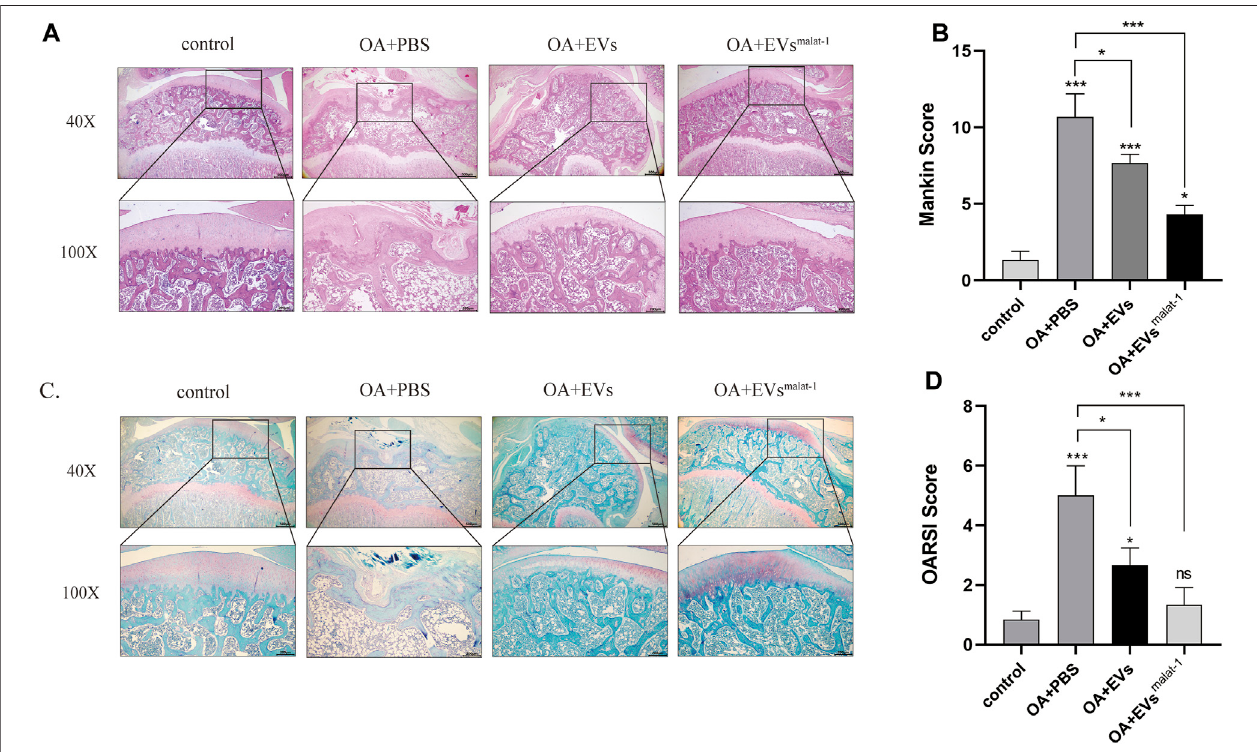
FIGURE6|(A) HaematoxylinandEosinstainingofSDratkneejointsafterinjectingEVsfor6 weeks.Scalebar:200 μ m(40X)and500 μ m(100X). (B) Themodi fi ed Mankin ’ s score of the SD rat knee joints. (C) Safranin O/Fast Green staining of SD rat knee joints after injecting EVs for 6 weeks. Scale bar: 200 μ m (40X) and 500 μ m (100X). (D) OARSI scores of the SD rat knee joints. * p < 0.05, ** p < 0.01, *** p < 0.001, vs. control group. n (cid:2) 3, one-way ANOVA for